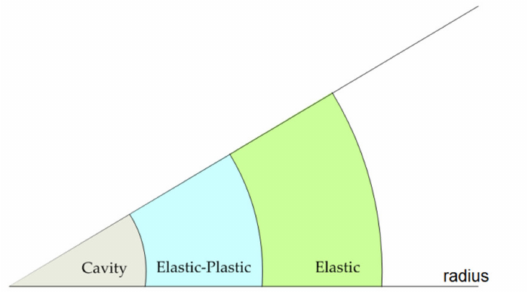
Figure 1. Description of soil behavior regions during cavity